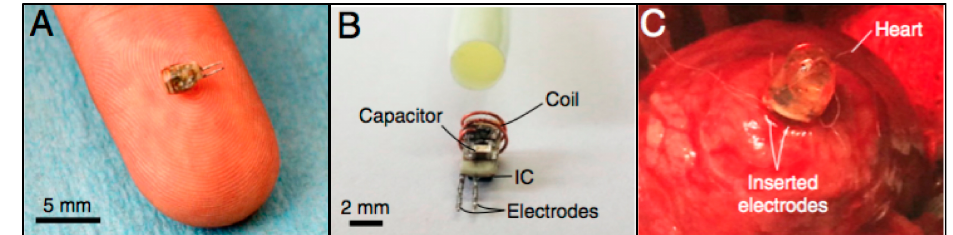
Figure 2. ( A ) Miniaturized wireless pacemaker on a human finger for scale; ( B ) device composition, displaying its coil, capacitor and inductive coupling (IC); and ( C ) an implanted device. Reproduced with permission from [12].